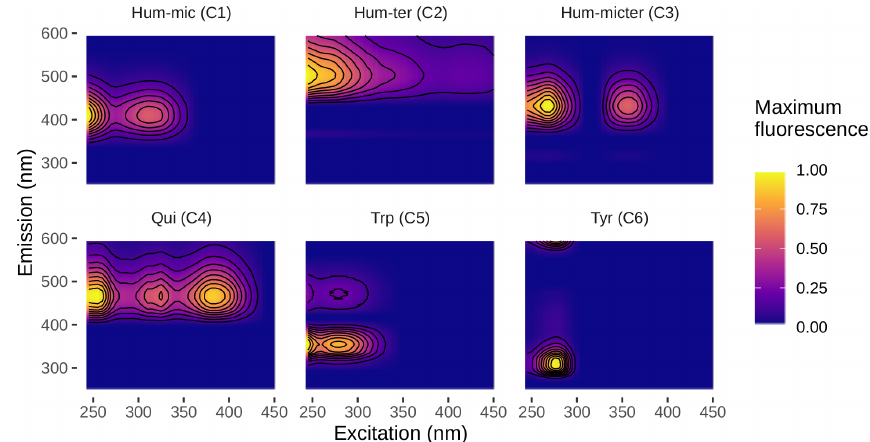
Figure 3. Fluorescence spectra of the identified PARAFAC components.